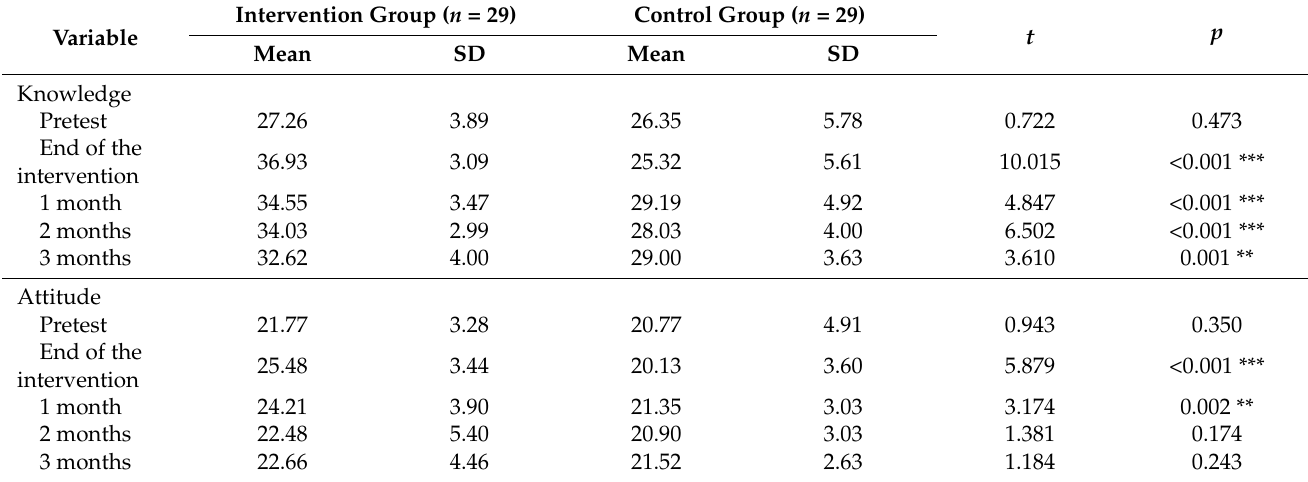
Table 2. Comparison of knowledge and attitude scores between two groups at different time points.